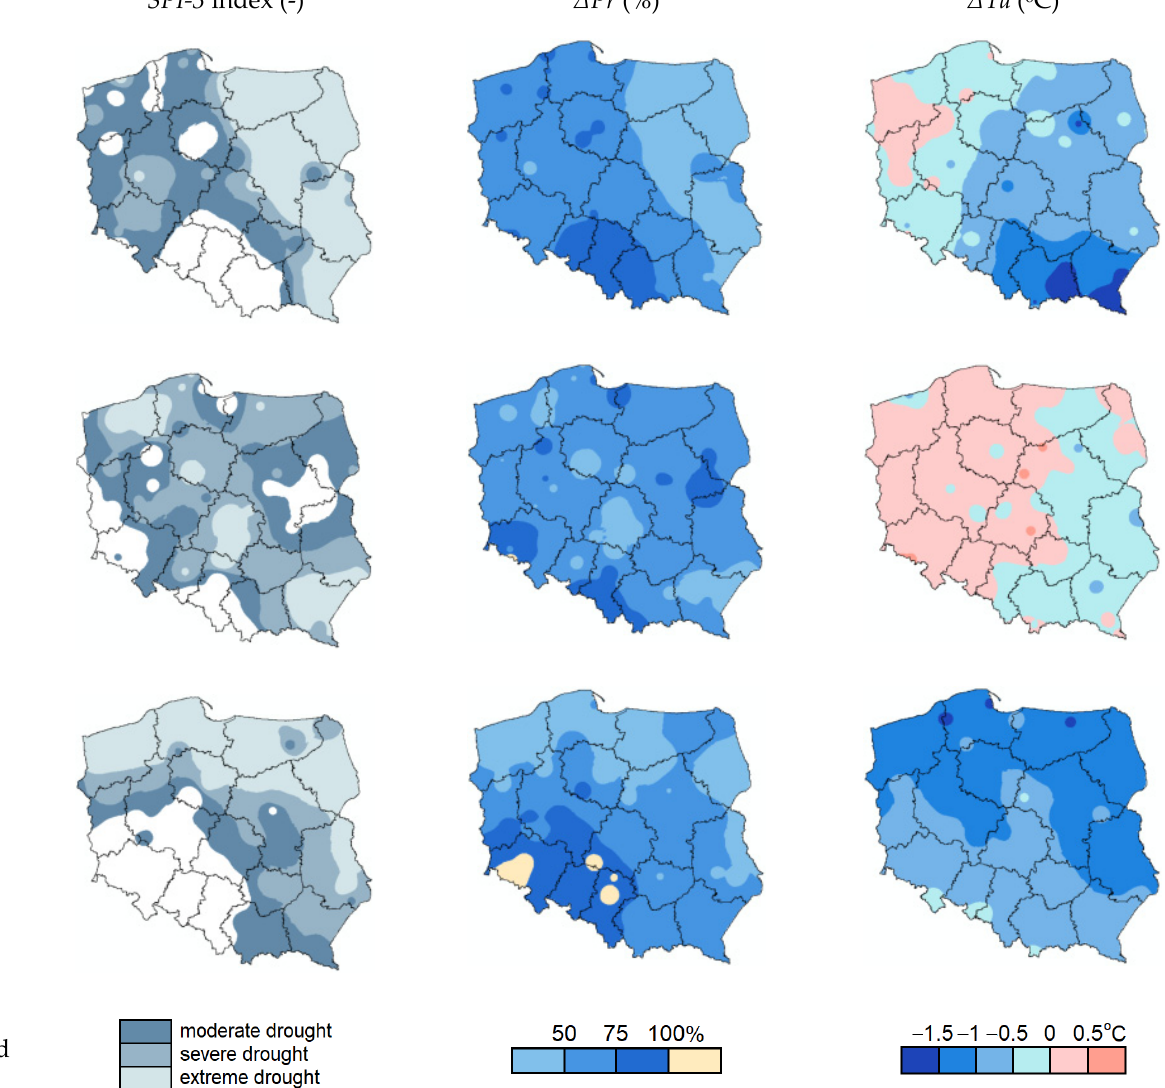
Figure 3. Spatial distribution of SPI-3 , Δ Pr and Δ Ta in Poland in spring in years when the SPI-3 value for a given area was ≤− 2 (1953, 1959 and 1974). Notes: Δ Pr (%)–precipitation sum expressed as a percentage of the climatic norm, Δ Ta (°C)–air temperature deviation from the climatic norm. In summer, MDr of extreme intensity occurred in 1992 in northeast Poland and in 2015 in east and south Poland (Figure 4). Meteorological drought was recorded at Δ Pr ≤ 50% of the climatic norm and Δ Ta ≥ of the climatic norm, fluctuating between 0.0 and 1.0 °C.